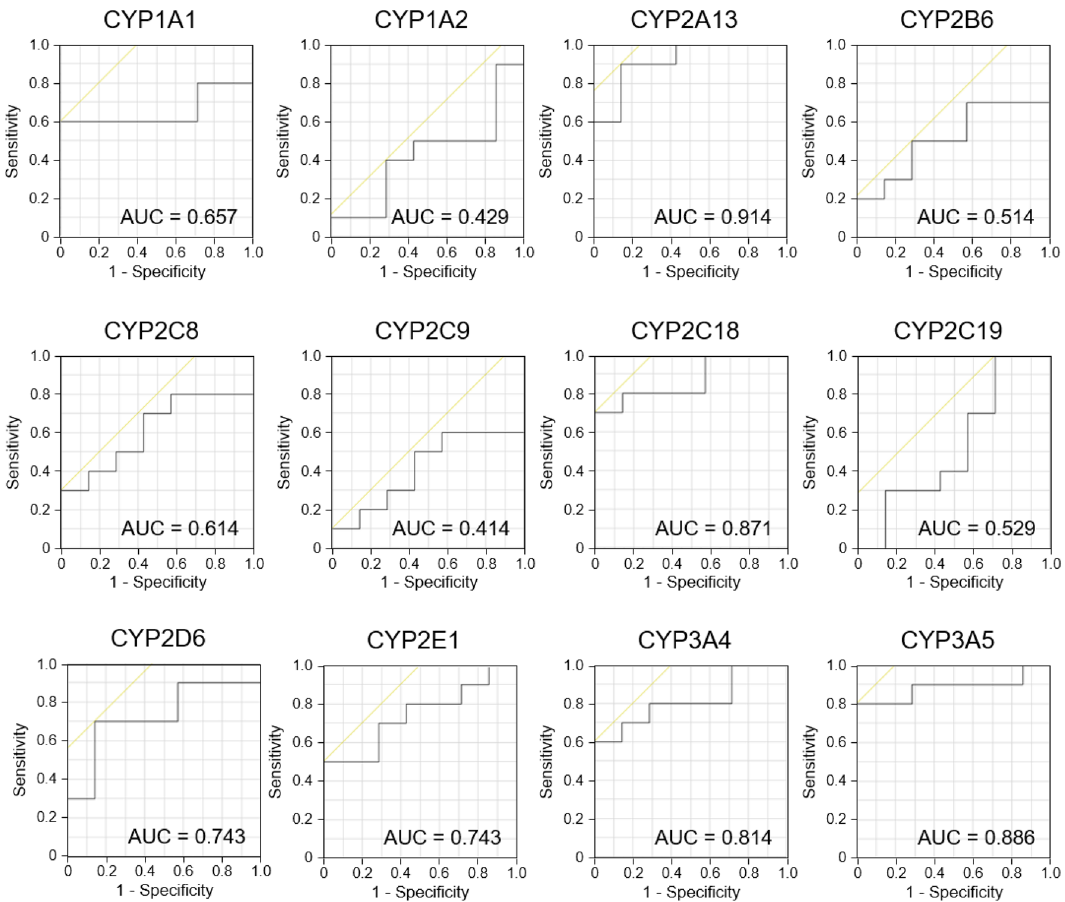
Figure 4. Receiver operating characteristic analysis of the P450 inhibition assay using Parkinson’s disease model rats. Values of the area under the curve are presented in each